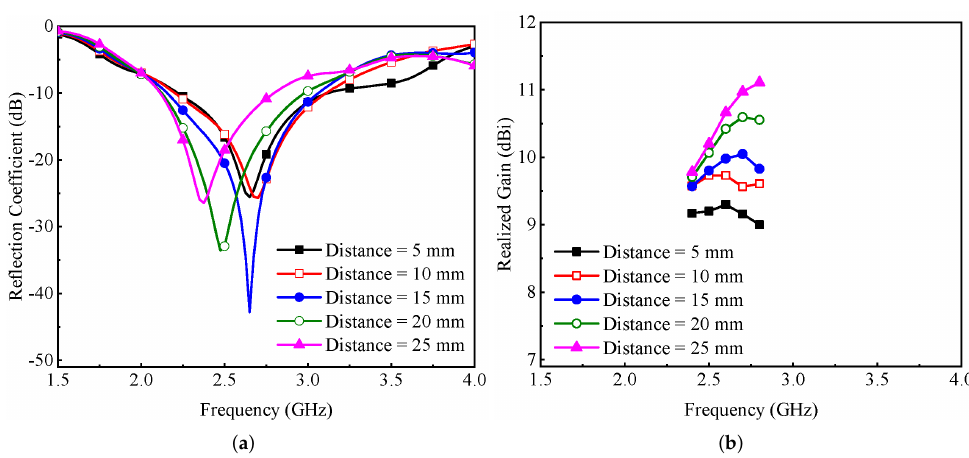
Figure 10. Effect of the distance between the radiating element and parasitic element on the antenna’s ( a ) reflection coefficient and ( b )